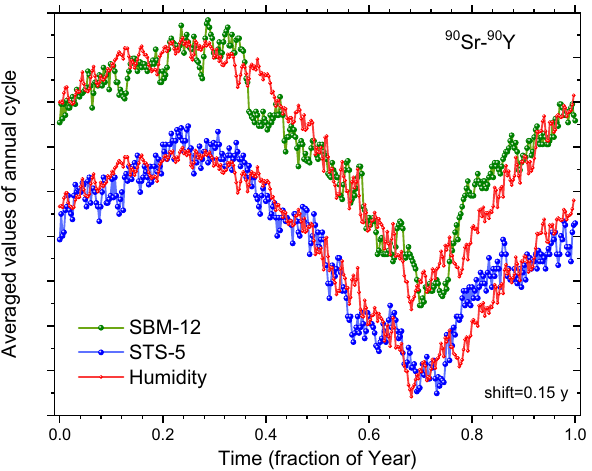
Figure 7. Averaged decay-corrected count rates of 90 Sr/ 90 Y beta decay obtained with the SBM-12 (top) and STS-5 G–M counter (bottom) as a function of time in the year, compared to absolute humidity in Moscow calculated from weather data shifted in time by 0.15 year to the right (line).